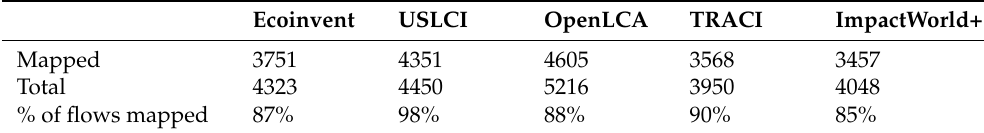
Table 4. Available mappings